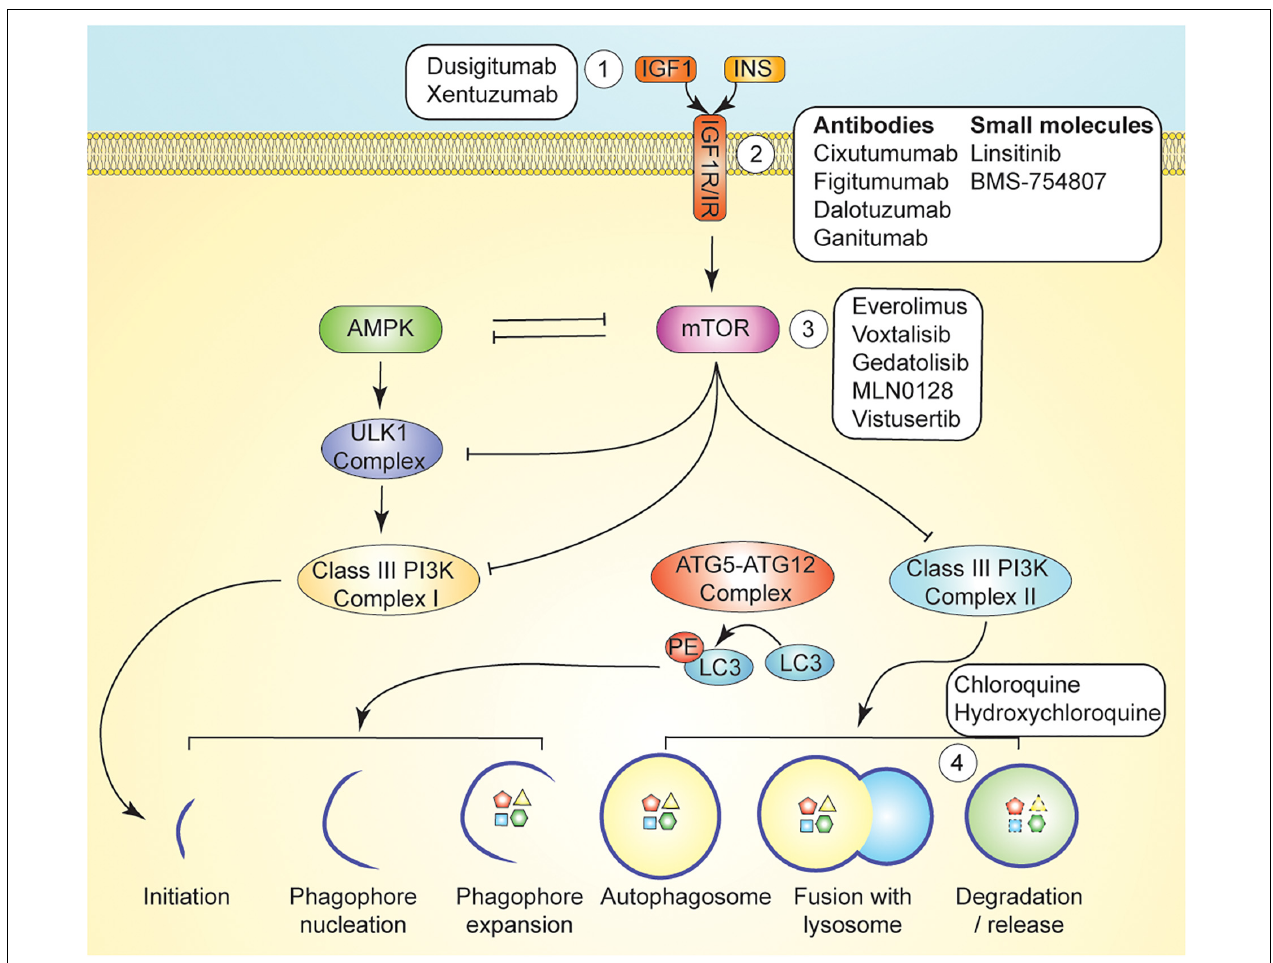
FIGURE 3 | Pharmacological Autophagy Modulation. mTOR signaling regulates induction of autophagy via inhibition of AMPK, ULK1, and Class III PI3K signaling. Autophagy can be induced by inhibition of growth factor signaling upstream of mTOR by ligand-targeting monoclonal antibodies (Kuma and Mizushima, 2010), receptor-targeting monoclonal antibodies, or small molecule inhibitors (e.g., AXL1717 and BMS-754807) (Mizushima et al., 2004). mTOR signaling is directly inhibited with compounds such as temsirolimus, and everolimus (Shaid et al., 2013). Autophagy can be inhibited with lysosomotropic agents such as chloroquine and hydroxychloroquine, which inhibit maturation of the autophagolysosome (Mizushima and Komatsu, 2011).